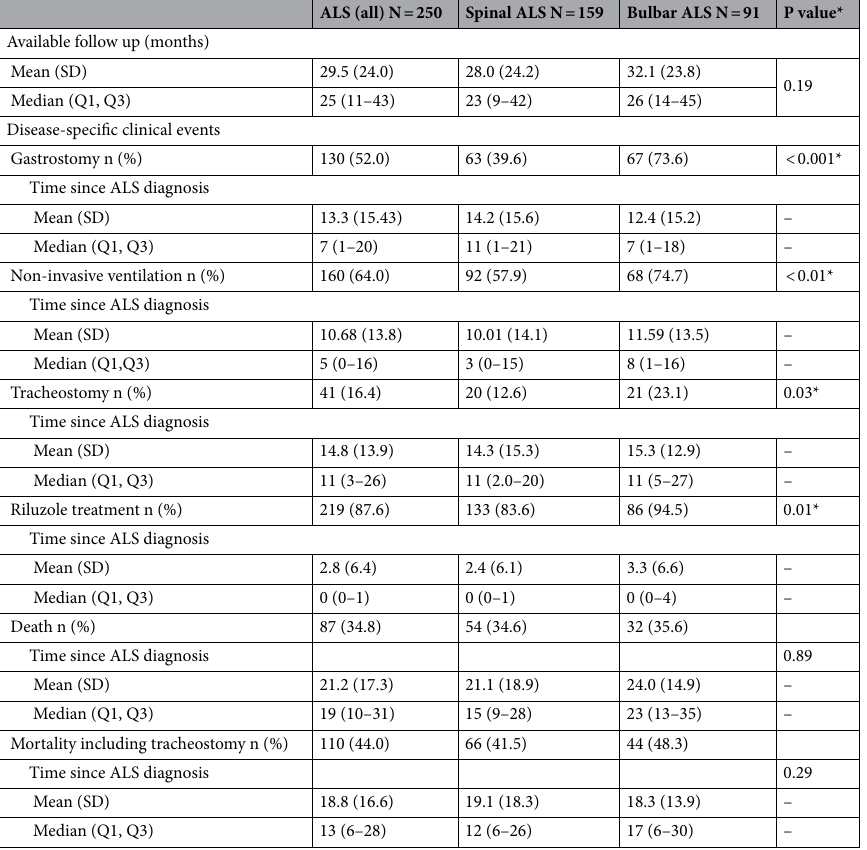
Table 4. Time from ALS diagnosis to relevant disease-specific events during follow-up. Follow-up analyses were performed using from diagnosis date until last datapoint available or end of study period. *Statistically significant differences between spinal and bulbar ALS were calculated using Pearson’s chi-squared tests for categorical variables and t-statistic tests for numeric